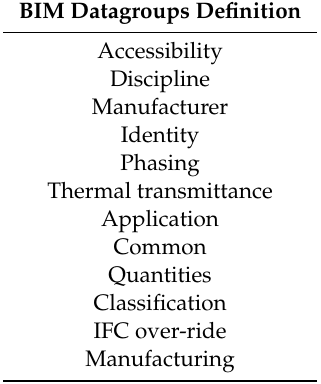
Table 10. Group set used to define the catalog or Datagroup of the constructive BIM elements E 1 and E 2 .